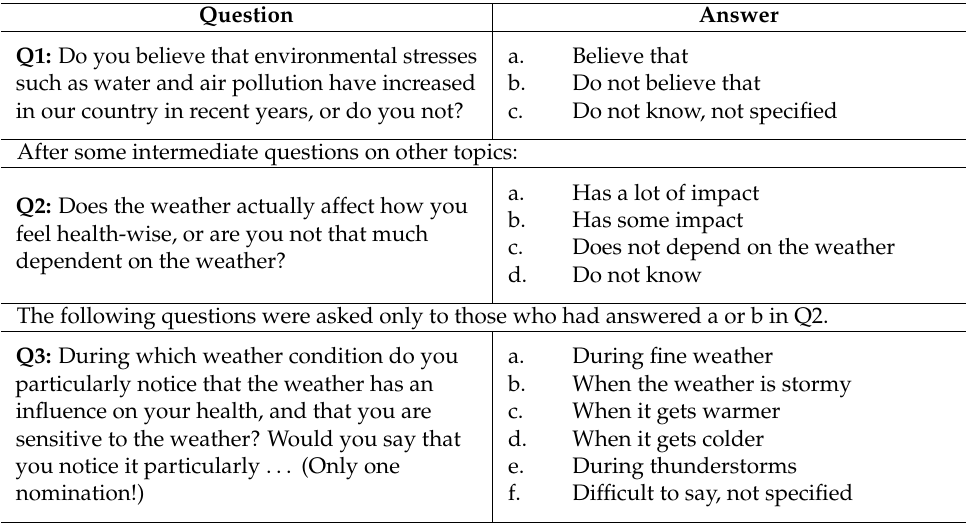
Table A1. Questionnaire 2021 (literally translated into